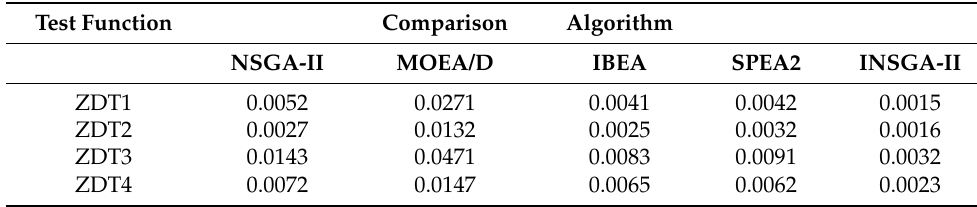
Table 2. IGD metric results for ZDT function.